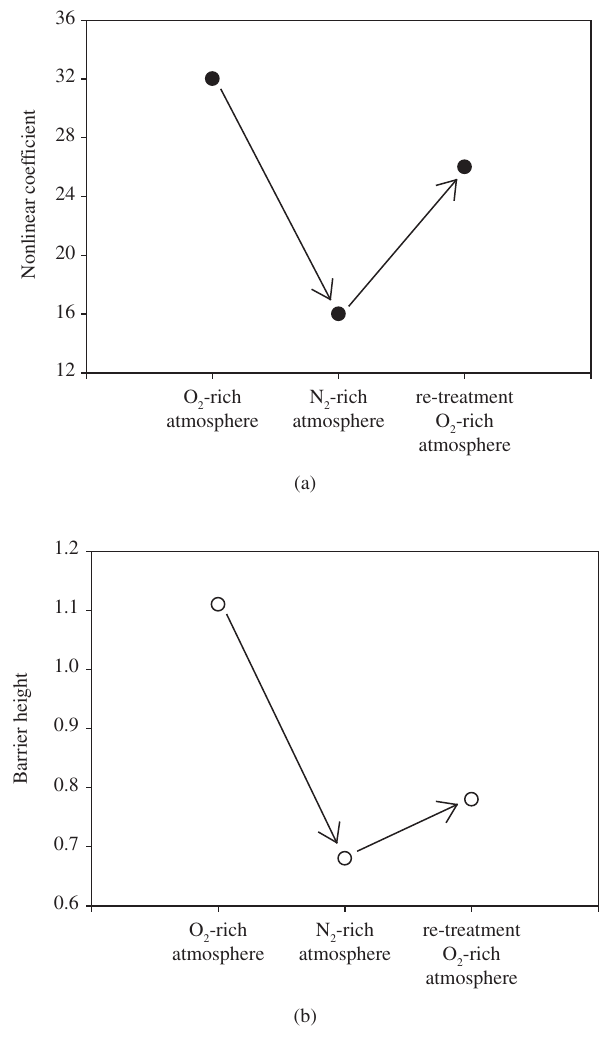
Figure 4. Exem�lificatio� of the i�fl�e�ce of thermal treatme�t i� differe�t Figure 5. Microstr�ct�re of S�O .M�O-�ased �olycrystalli�e ceramics. Com- 2 atmos�heres to the de�se S�O -�ased �olycrystalli�e ceramics. a) Here, it ca� �ared to the S�O .CoO-�ased �olycrystalli�e ceramics (which is ill�strated i� 2 2 �e show� the reversi�ility of the �o�li�ear coefficie�t o�tai�ed from I-V c�rves Fig�re 2�) it ca� �e �oted the �rese�ce of �reci�itates at grai� �o��dary tri�le- after thermal treatme�t at oxidizi�g atmos�here, N -rich atmos�here a�d agai� �oi�t so that heteroge�eity j��ctio�s arises. Lo�ger si�teri�g times i�crease 2 at oxidizi�g atmos�here; a�d �) The same �ehavior is o�tai�ed co�cer�i�g the �reci�itatio� of M� S�O a�d the heteroge�eity of j��ctio�s 45,46 2 4 �arrier height val�es of the �ote�tial �arrier formed at grai� �o��daries.